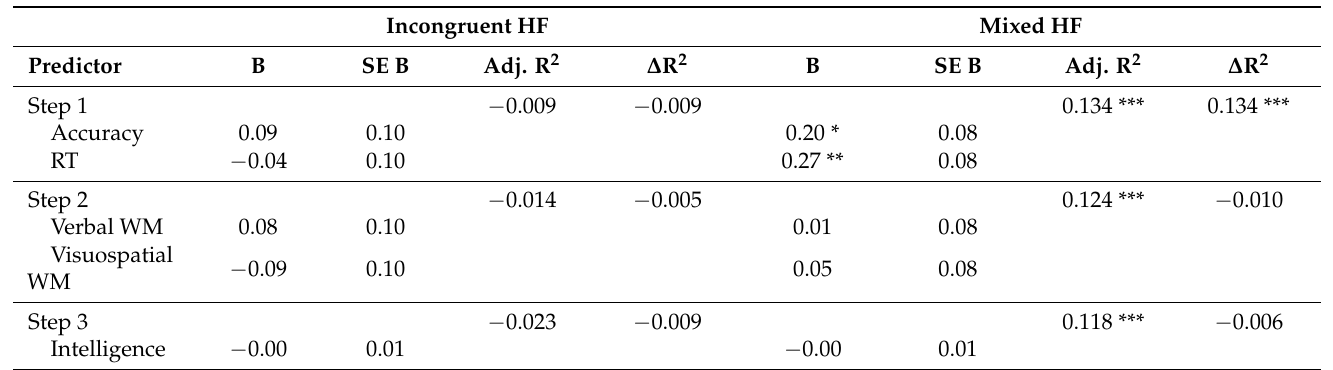
Figure 3. Shared and unique variances between intelligence, verbal WM, and inhibition accuracy. Table 3. Results of the hierarchical regressions predicting PES in the incongruent and mixed HF. Incongruent HF Mixed